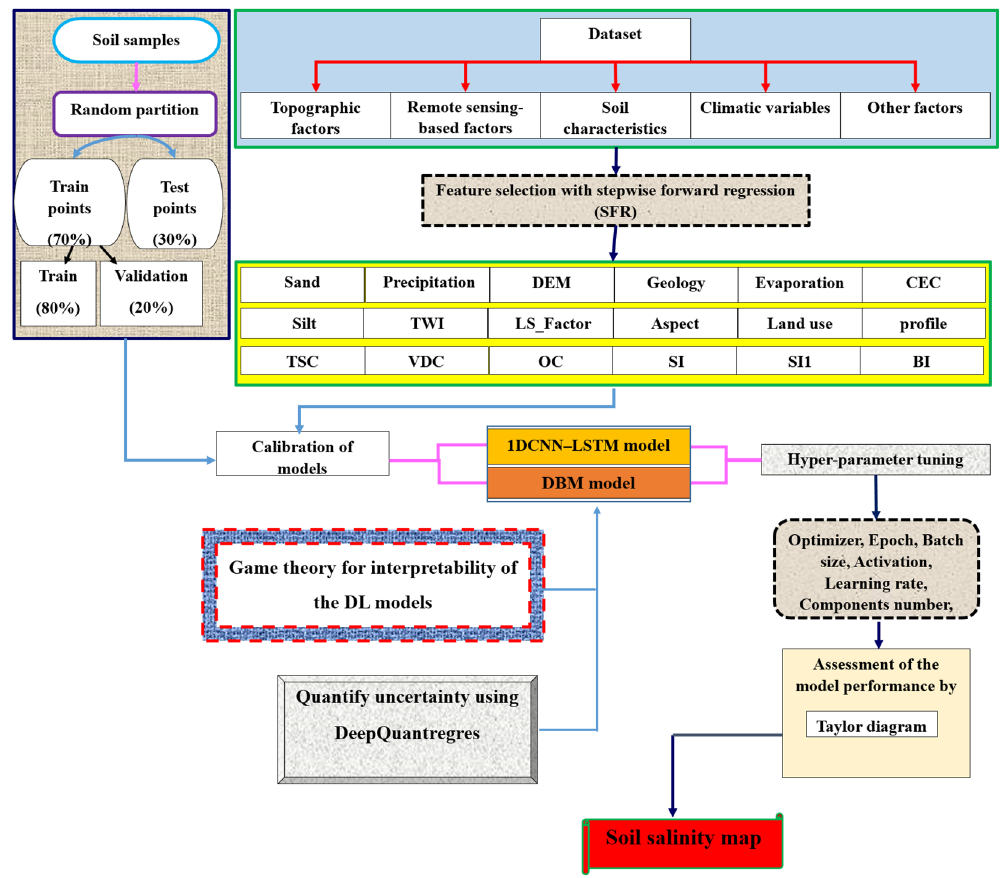
Figure 5. Flowchart of the methodology used to map soil salinity in the study area.